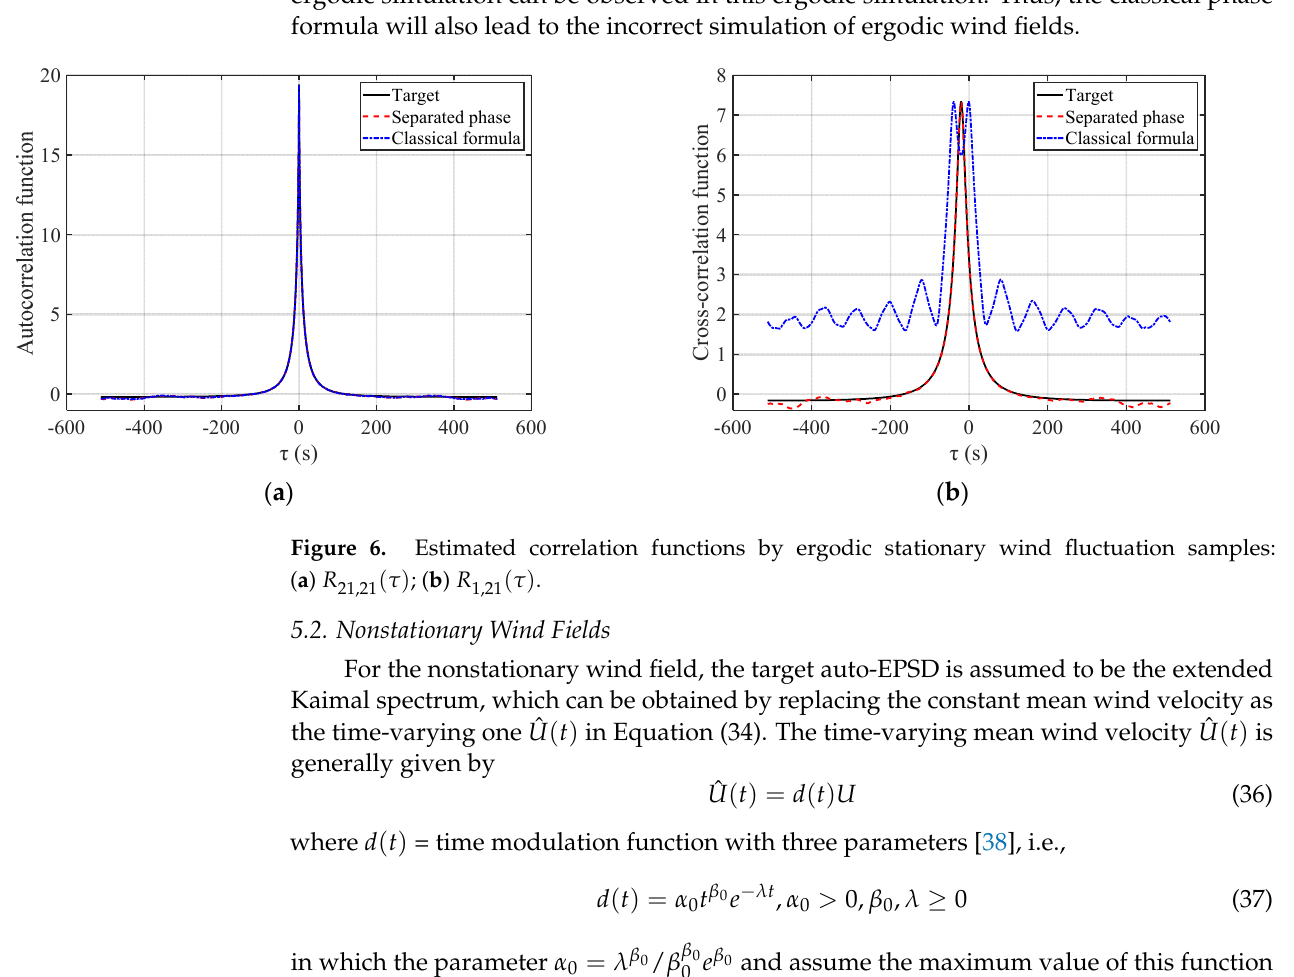
Figure 5. Simulated ergodic stationary wind fluctuation samples (first 1024 s): ( a ) Point 1; ( b ) Point 21; ( c ) Point 41.